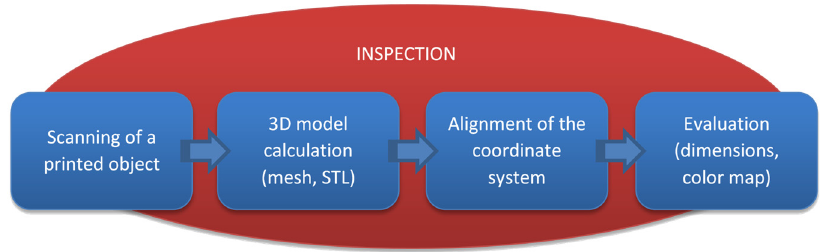
Figure 4. Inspection stages using a 3D scanner.